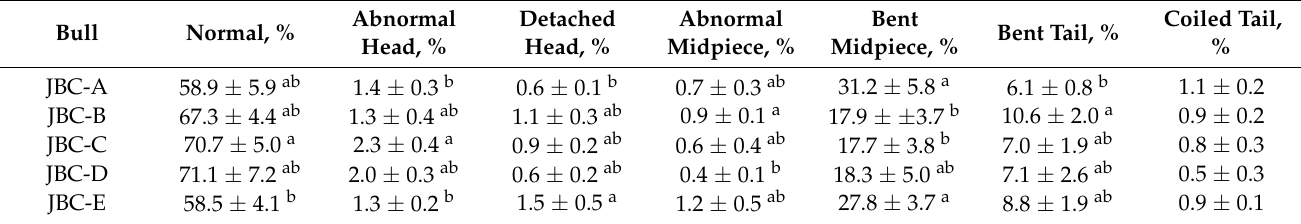
Table 4. Morphology of fresh sperm from individual JBC bulls, as assessed by Diff-Quik staining.